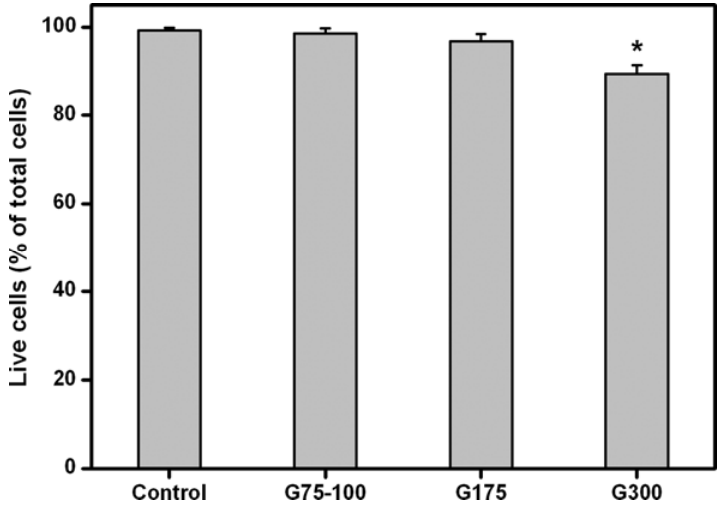
Figure 4. Mean percentage of live cells in the ARPE-19 cultures exposed to various dissolved gelatin materials as measured by the Live/Dead